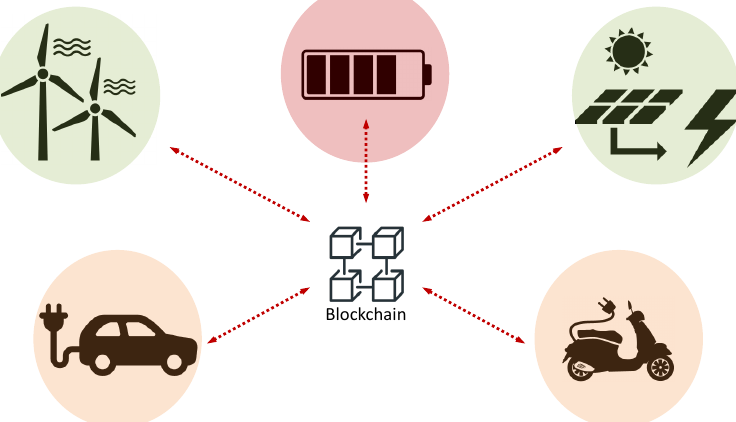
Figure 3. Energy Marketplace: Energy producers, energy aggregators, and electric vehicles mingle in a real-time, fine-granularity trading, to improve the fair distribution of energy and to prevent energy